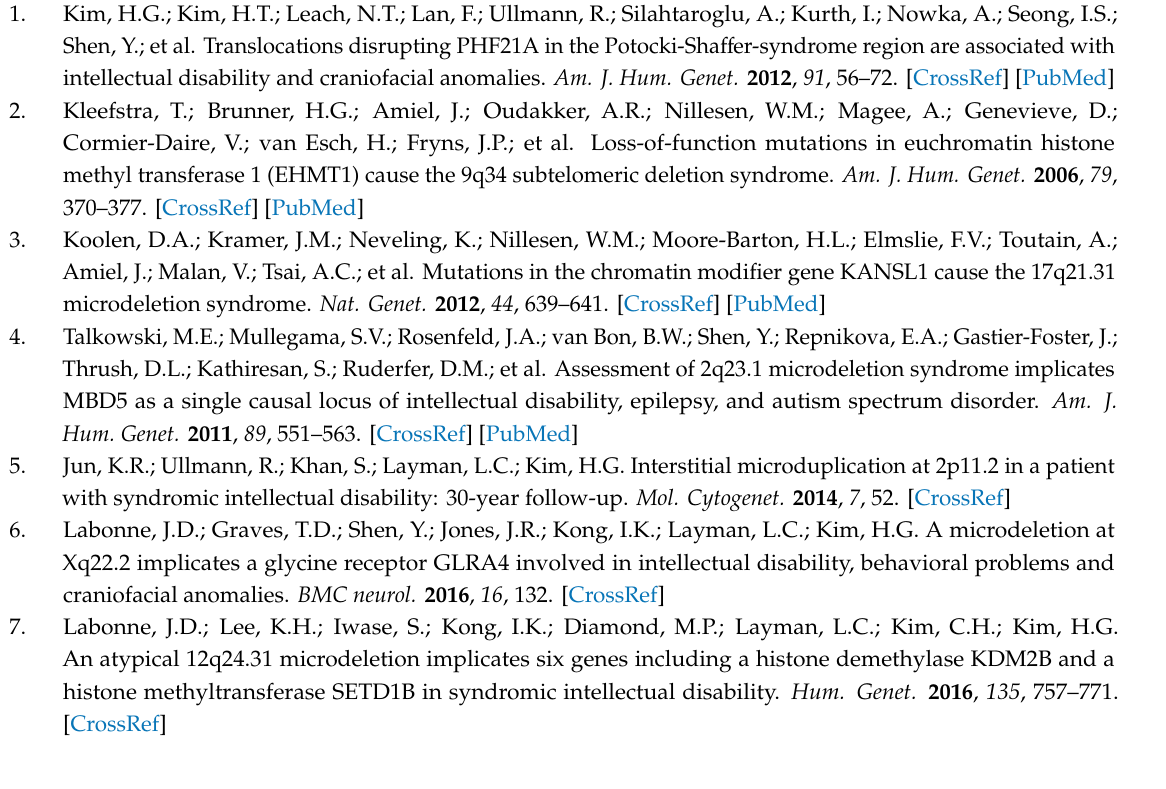
Table S1: Primers used for qPCR and